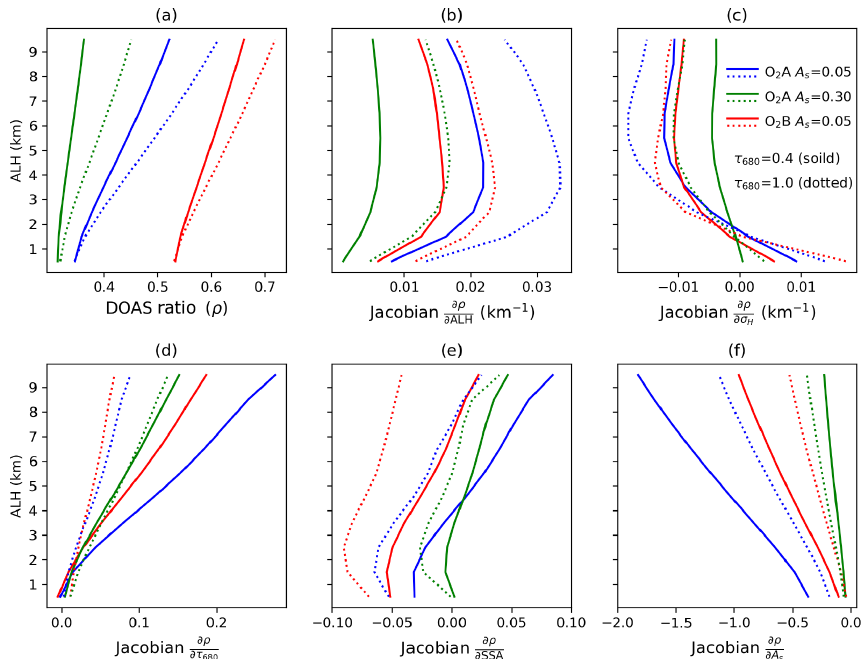
Figure A1. UNL-VRTM-simulated DOAS ratios ρ in EPIC O 2 A and B band (a) and their Jacobian gradients with respect to ALH (b) , half-width parameter σ H for the quasi-Gaussian aerosol vertical profile (c) , 680nm AOD τ 680 (d) , SSA (e) , and surface reflectance A s (f) . The y axis represents aerosols being present at various ALH values. Three colors indicate ρ and its Jacobians for the O 2 A band with A s = 0 . 05 (blue), the O 2 A band with A s = 0 . 30 (green), and the O 2 B band with A s = 0 . 05 (red). Two AOD loadings are indicated by the solid ( τ 680 = 0 . 4) and dotted ( τ 680 = 1 . 0) lines, respectively. Simulations are performed with the same aerosol model and observation geometry in Fig.